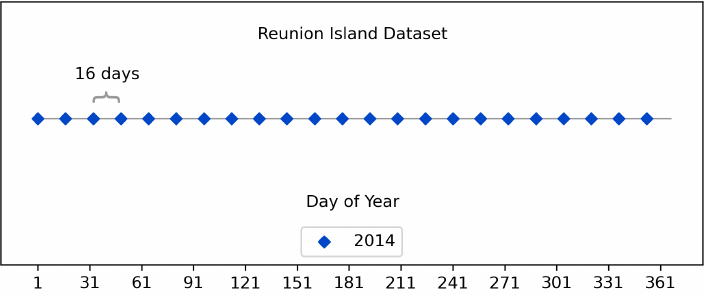
Figure 4. Temporal distribution of satellite images in the Reunion Island dataset.